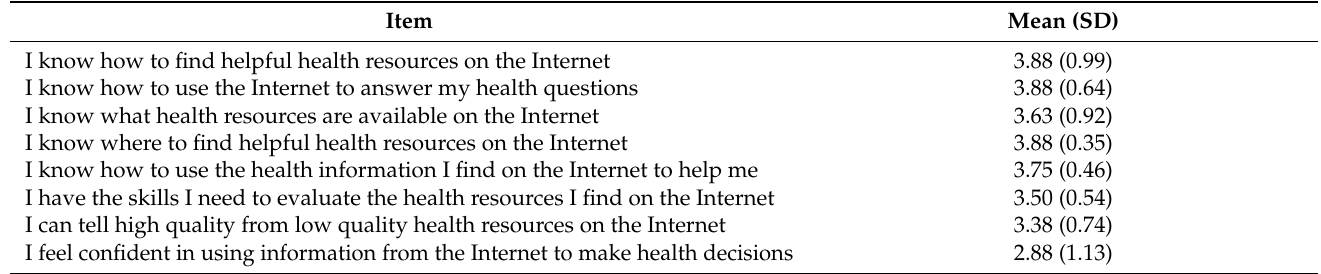
Table 2. eHealth Literacy Scale (eHEALS) mean items scores for Design Circle